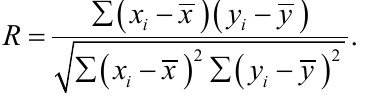
Fig. 1: Bathymetrical location of the study area in NBoB and the sample station (red dot). The map was plotted using Natural Earth raster + vector data (naturalearthdata.com). The blue color difference indicates the depth (m).